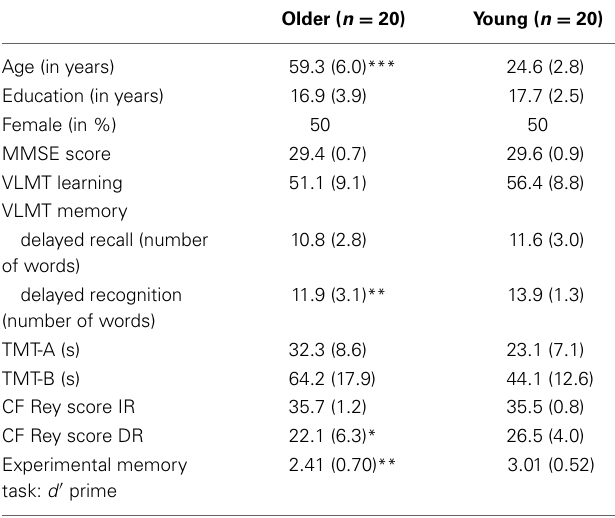
Table 1 | Demographic and cognitive characteristics of the